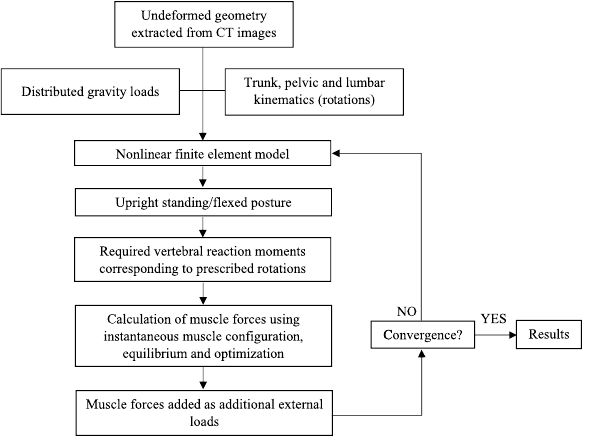
Figure 1. The workflow of the musculoskeletal (MS) model to calculate unknown muscle forces and spinal